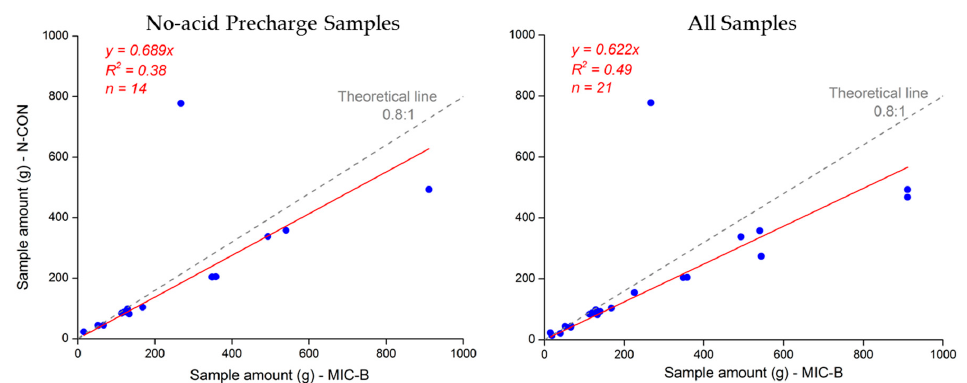
Figure 4. Volume collected by collocated samplers using two separate sampler types (NCON and the MIC-B Style) at National Central University (NCU) Campus, Taiwan. Acid precharge sample volumes for both samplers do not include acid volume added.